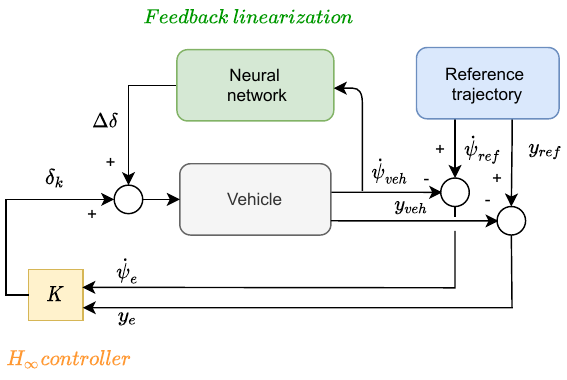
Figure 10. Structure of the proposed control